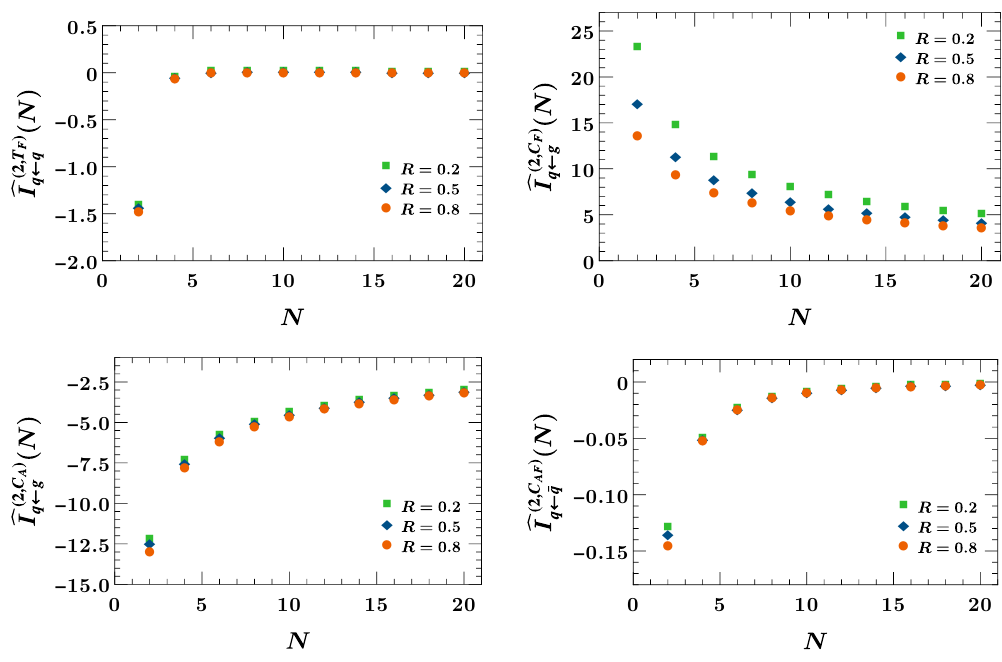
Figure 2 . Non-logarithmic terms of the NNLO matching kernels defined in